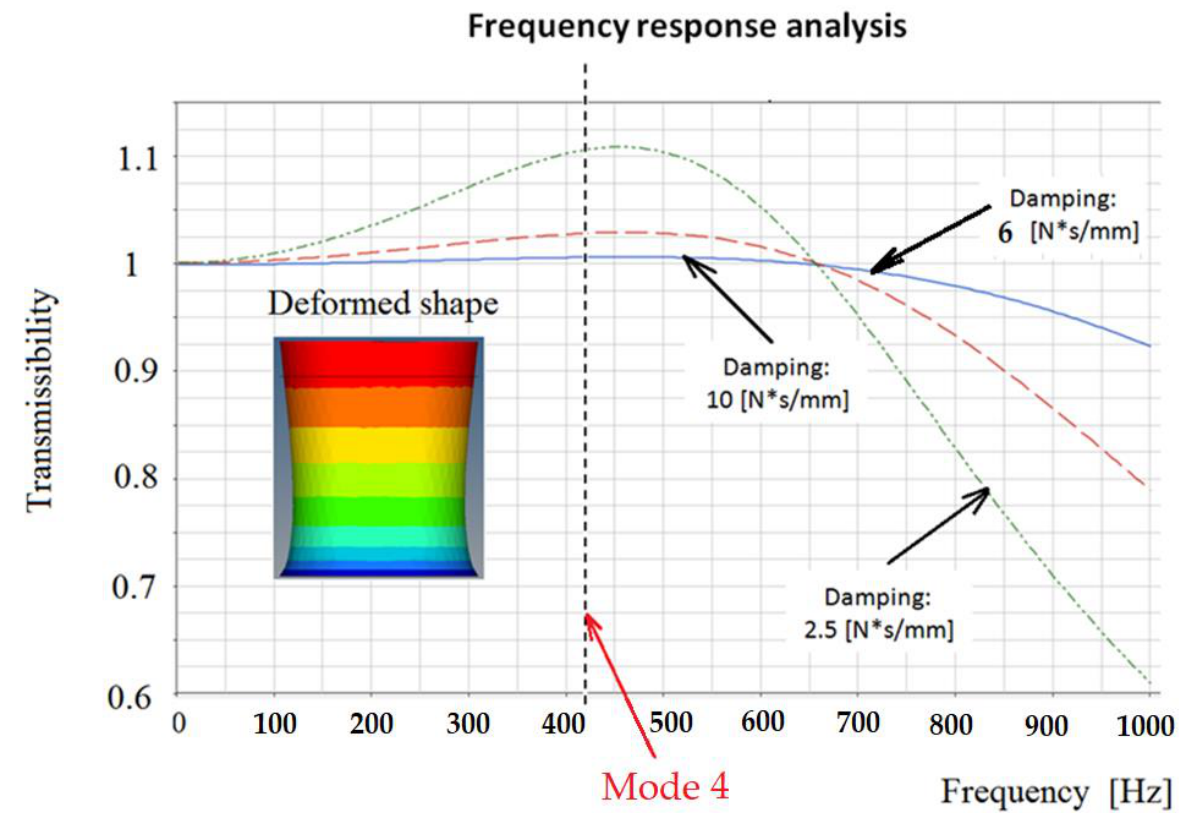
Figure 8. Frequency response for an inertial damper with steel balls.